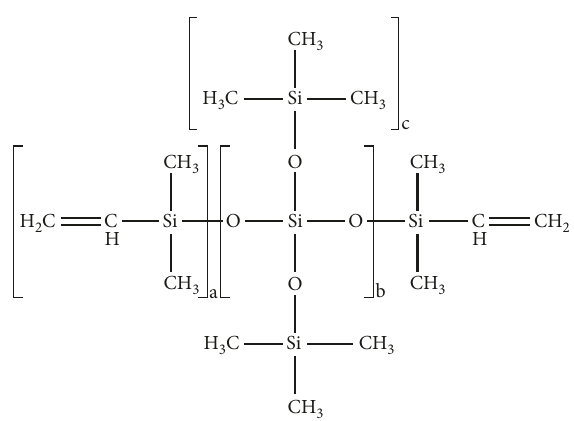
Figure 1: Structure of methyl vinyl MQ silicone